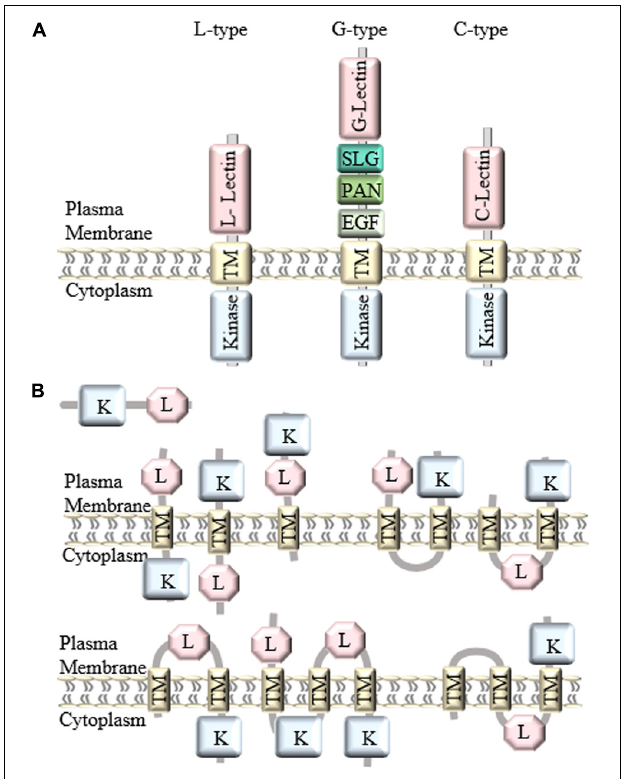
FIGURE 1 | Classification and structure of LecRLKs. (A) There are three different types of LecRLKs based on the distinct extracellular domain: L-type LecRLKs with a legume like lectin domain, G-type LecRLKs with an α -mannose binding bulb lectin domain, an S-locus glycoprotein domain (SLG), a PAN and/or Epidermal Growth Factor (EGF) domain, and C-type LecRLKs with a calcium-dependent lectin domain. (B) Other predicted structures of LecRLKs. Some LecRLKs are predicted to have no transmembrane domain or kinase domain or have multiple transmembrane domains and different